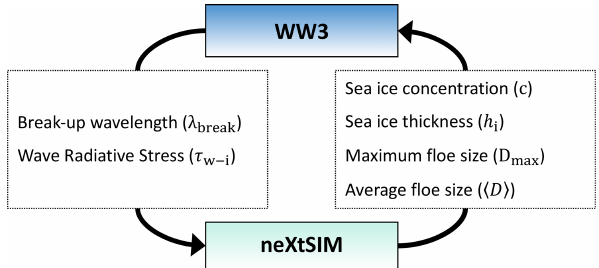
Figure 1. Summary of the exchanged variables in the neXtSIM– WW3 coupling framework.